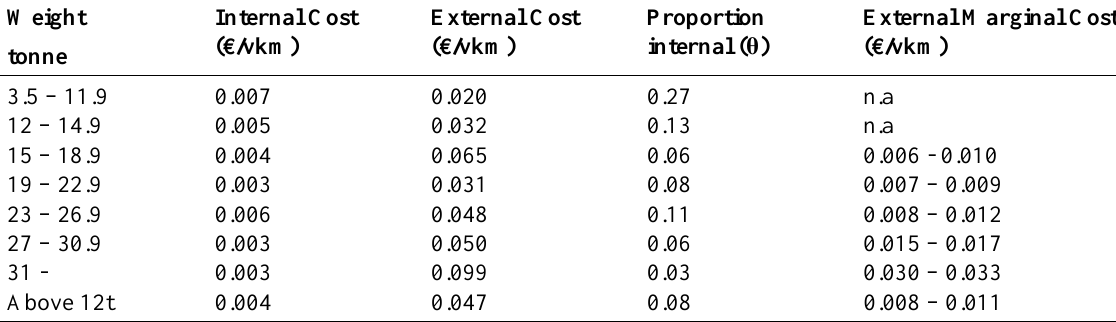
Table 3. External marginal accident cost, HGVs, Sweden